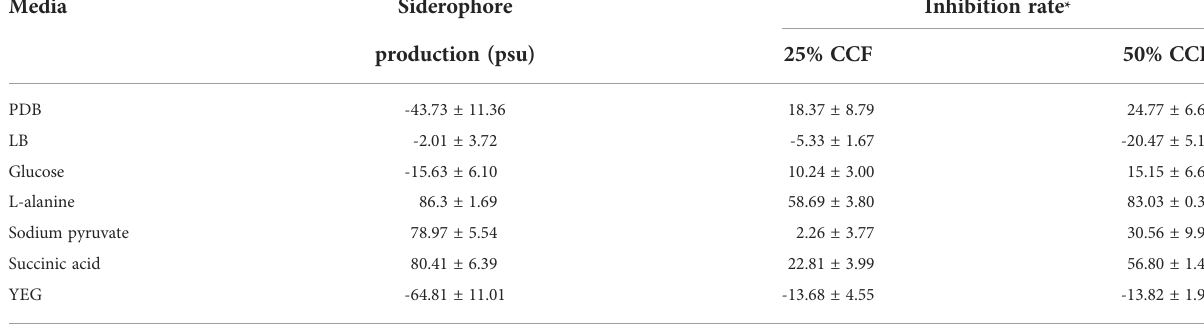
TABLE 5 Detection of siderophores (psu) produced by P. resinovorans SZMC 25872 in CCF samples, and the growth inhibition (%) of A. tumefaciens SZMC 14557 caused by 25 and 50% concentrations of CCF (means of 3 replicates ± standard deviations).